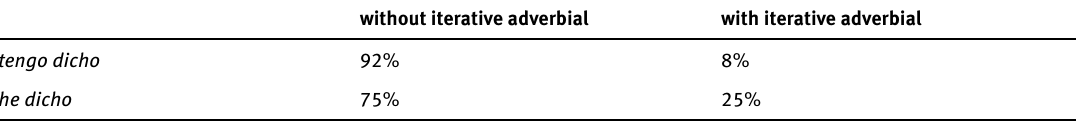
Table 3. Tengo dicho and he dicho as expressions of a reproachful reminder with and without iterative adverbials without iterative adverbial with iterative